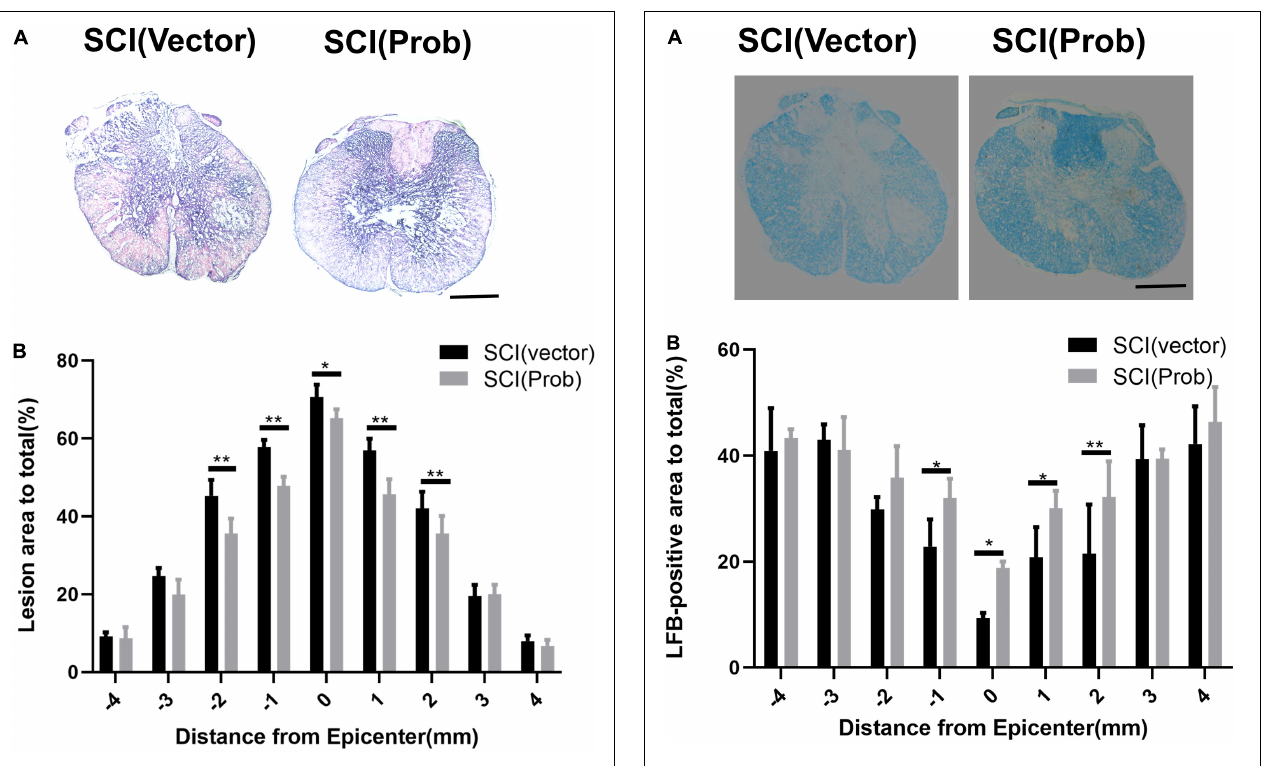
FIGURE 5 | Quantitative analysis of the effect of Probenecid on lesion areas. (A) Representative pictures of hematoxylin-eosin (HE) staining in the transverse sections of 2 mm rostral to the epicenter of spinal cords. (B) Quantitative analysis of lesion areas in different groups at different distances from the epicenter (0 mm) and 1, 2, 3, and 4 mm rostral (+) and caudal (–) from the epicenter (* p < 0.05, ** p < 0.01 n = 6). Scale bar: 500 µ m.